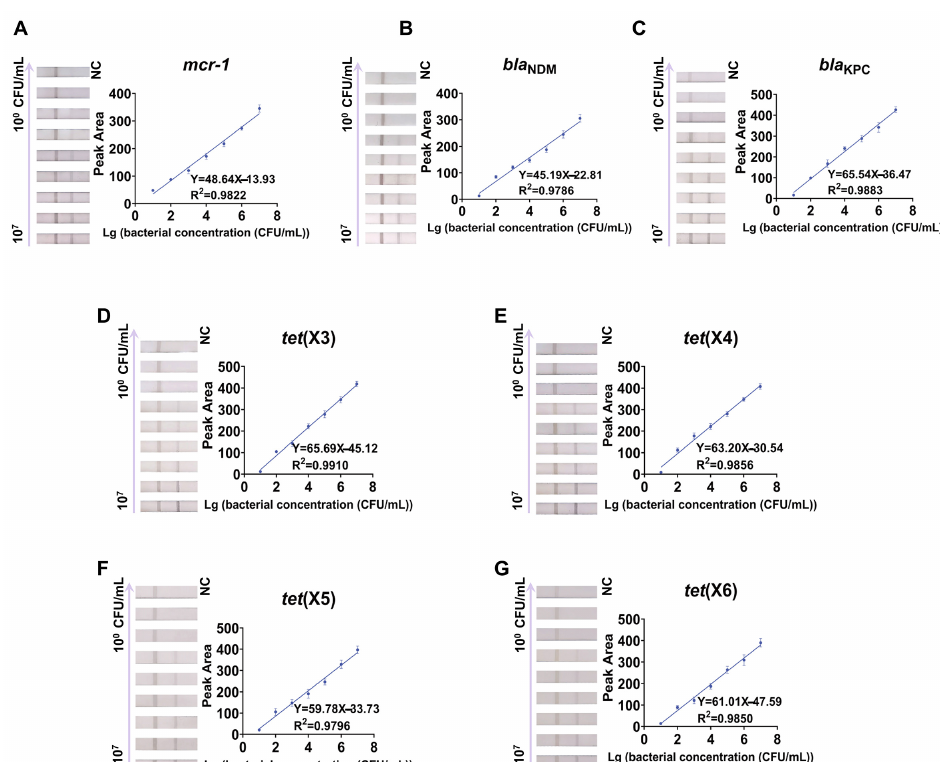
Figure 4. Sensitivity for detecting pan-drug-resistant genes in urine samples. Linear regression and actual images. ( A ) mcr-1 , ( B ) bla NDM , ( C ) bla KPC, ( D ) tet (X3), ( E ) tet (X4), ( F ) tet (X5), ( G ) tet (X6). NC, negative control.